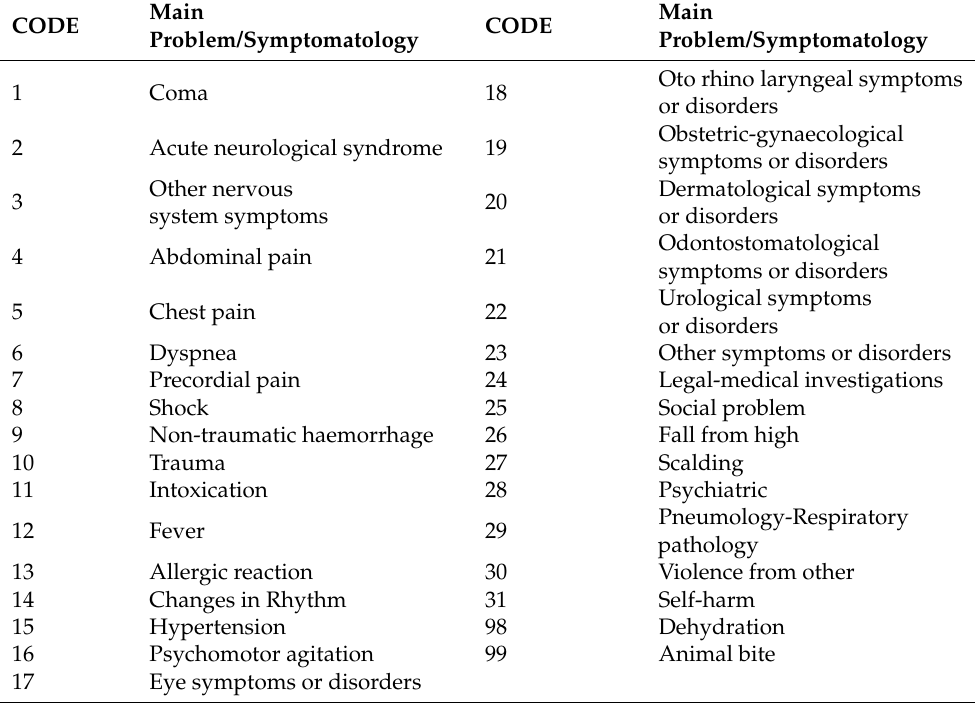
Table 1. Main symptoms entering the emergency room and identification